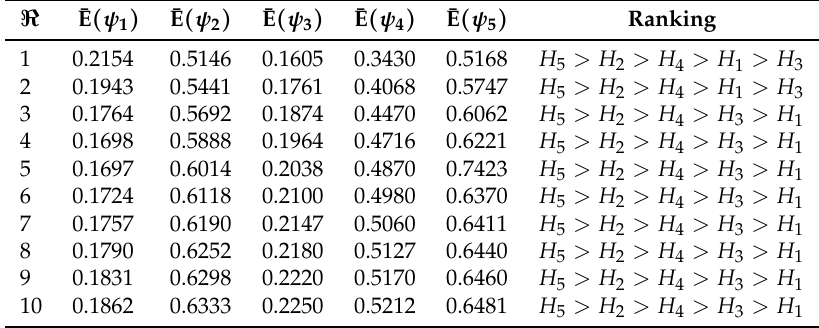
Table 2. Ranking order of influence of the parameters (cid:60) , using a PFDWA operator.